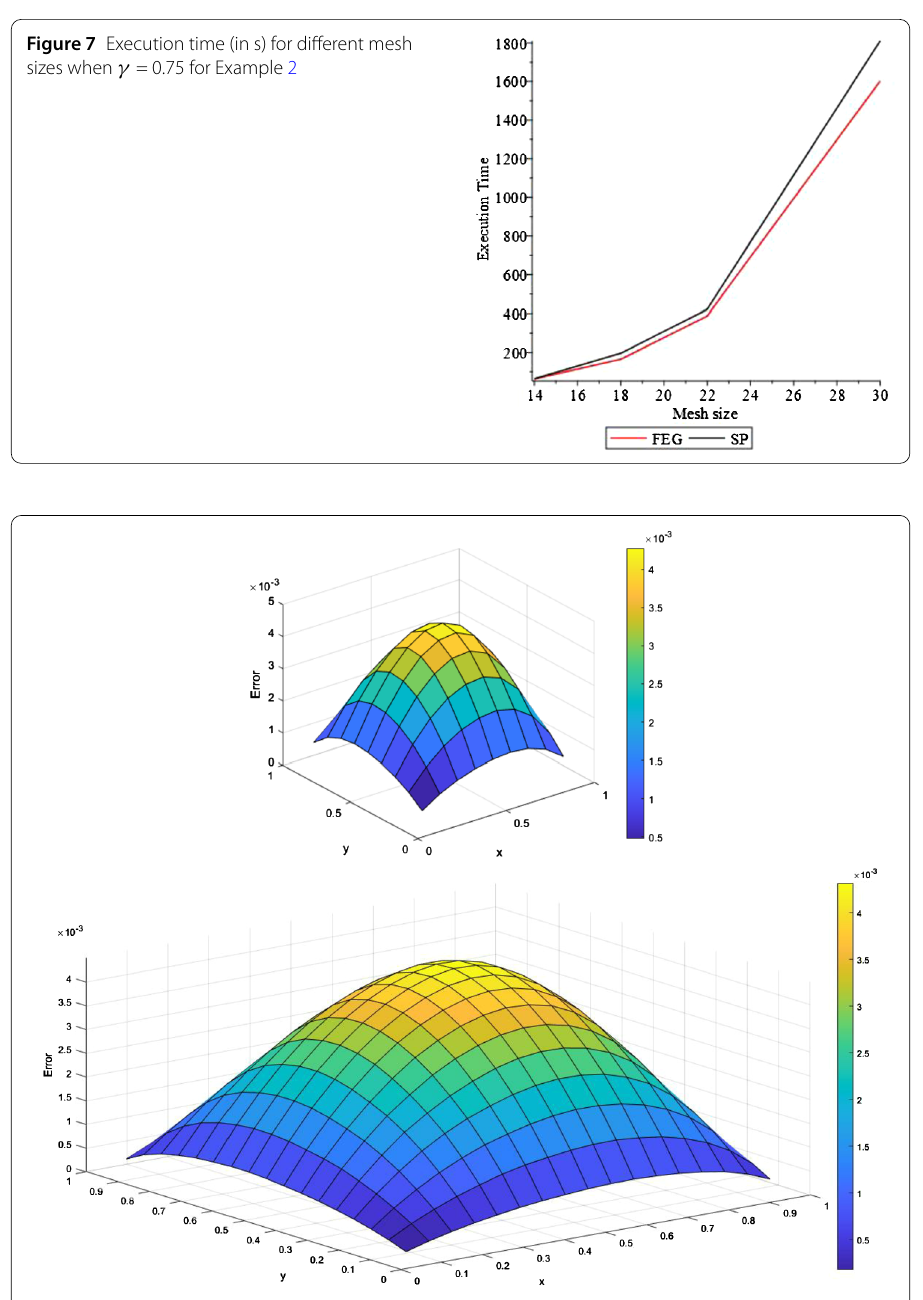
Figure 8 Graphs of maximum errors using HEGM with γ = 0.5, τ = 1/20 and h = 1 problem 1